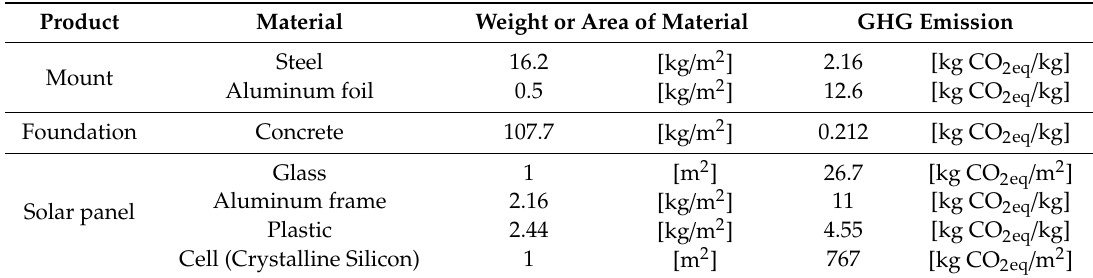
Table 2. Fundamental data for calculating GHG